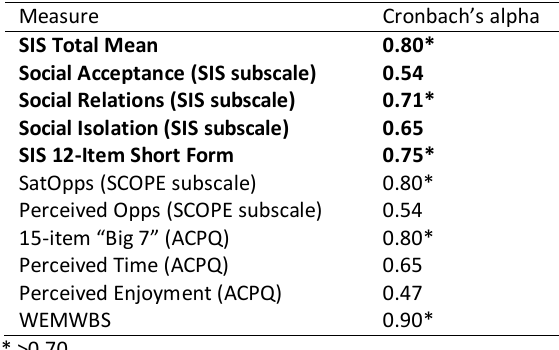
Table 2. Cronbach’s alpha for each questionnaire at time 1.